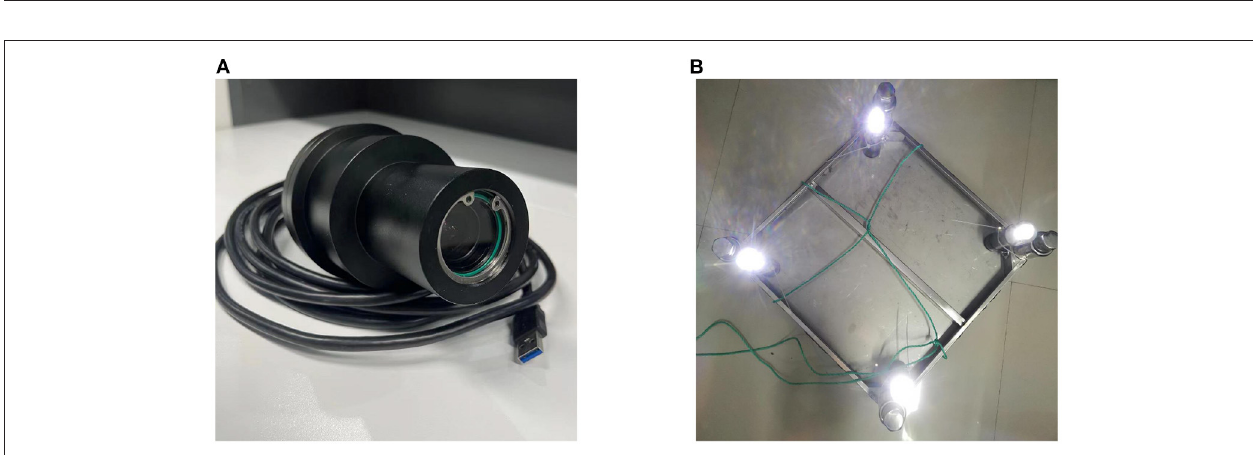
Frontiers in Neurorobotics |